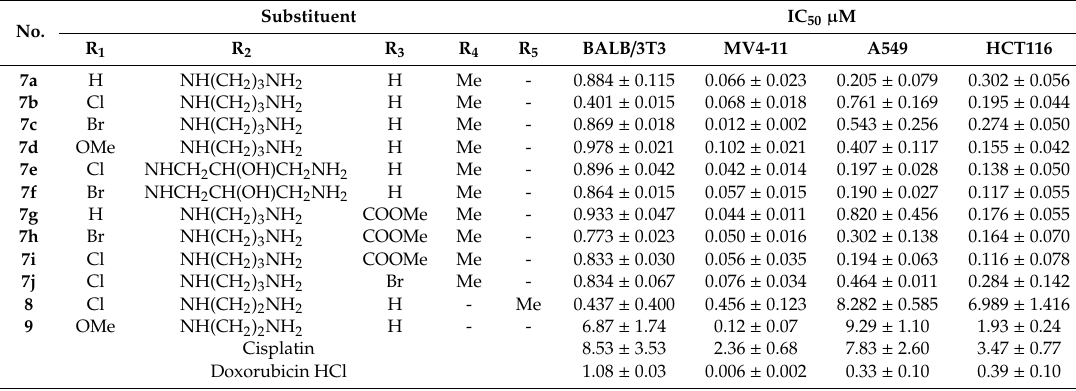
Table 1. Cytotoxic e ff ect of neocryptolepine derivatives [13–16].